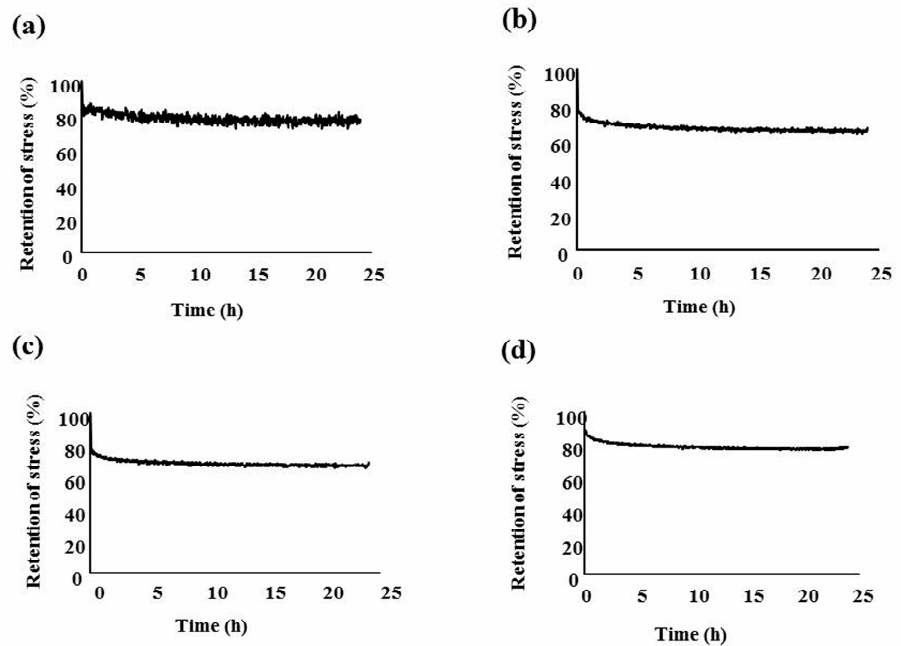
Figure 5. Rate of retention stress ( a ) rate of retention stress of 16 PEEK (Polyetheretherketone); ( b ) rate of retention stress of 16-22PEEK; ( c ) rate of retention stress of 19-25PEEK; ( d ) rate of retention stress of Ni-Ti. Table 1. Rate of retention stress after 24 h. Values are given as mean (SD).